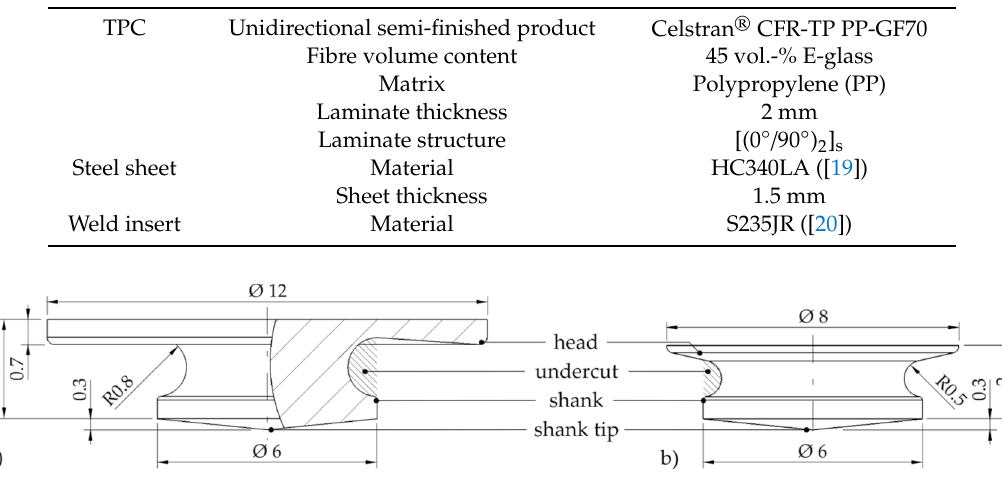
Figure 3. Prototypic weld inserts for process-integrated embedding: ( a ) type A, ( b ) type B.